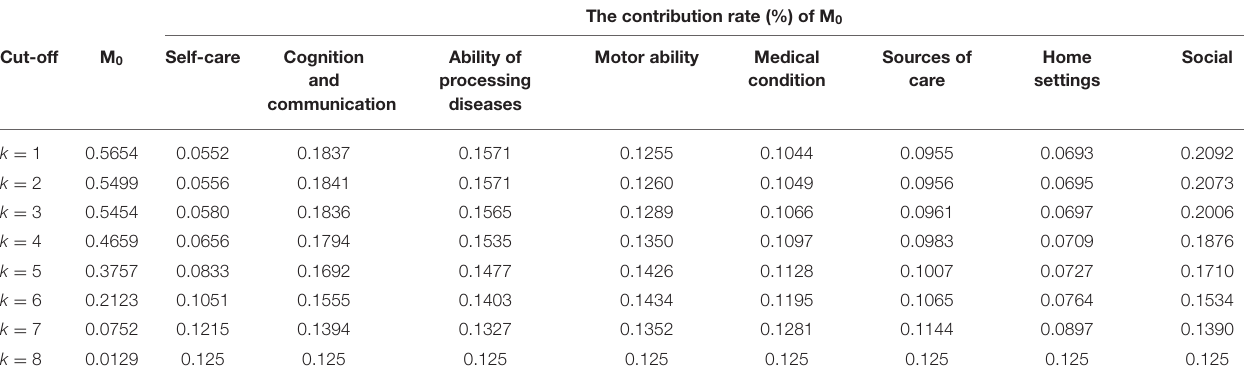
TABLE 8 | The contribution of multidimensional disability indexes (M 0 ) after adjustment. Cut-off M 0 Self-care Cognition